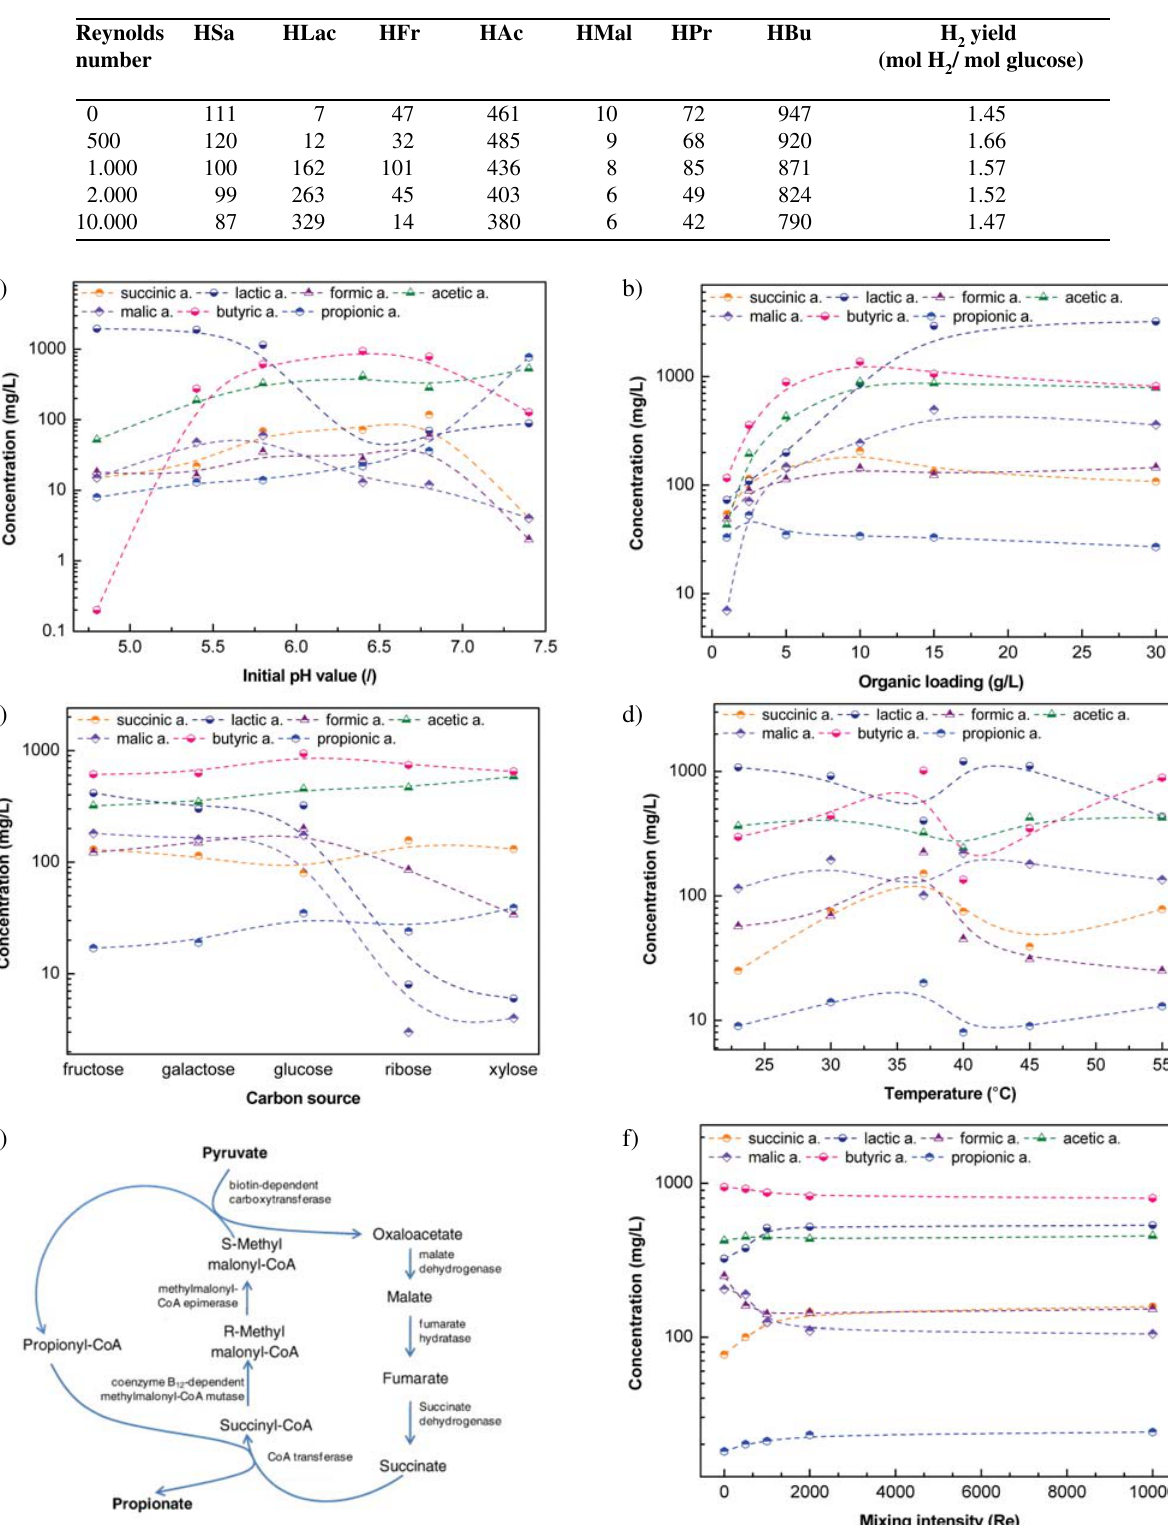
Figure 5. Concentration of VFA as a function of initial pH value (a), organic loading (b), carbon source (c), temperature (d) and mixing intensity (e). Lines show trends. Schematic representatation of propionate production in Propionibacterium freudenreichii (f). 36